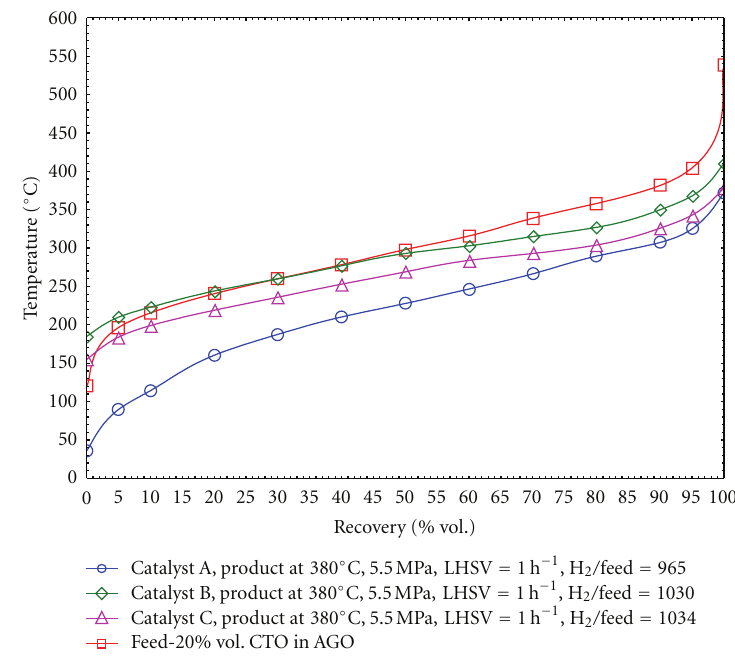
Figure 4: Simulated distillation curves of the feedstock and selected products of